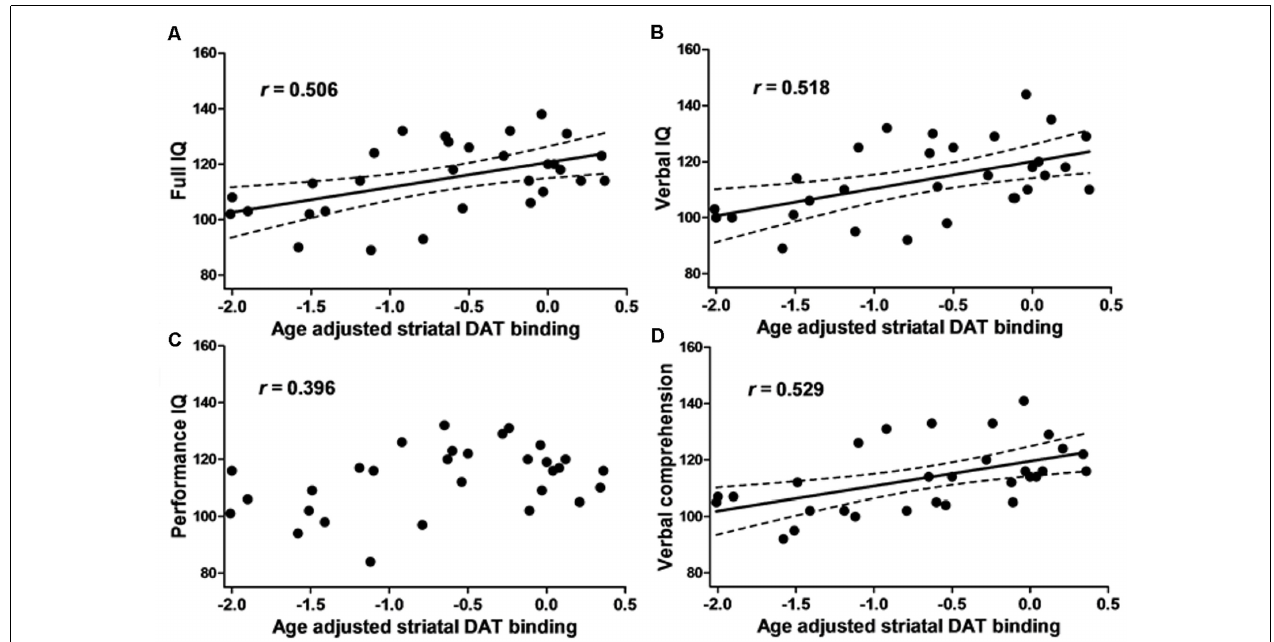
FIGURE 2 | The relationship between the intelligence quotient (IQ) and dopamine transporter (DAT) binding. The scatter plot showing the age-adjusted intellectual score and age-adjusted right and left averaged striatal specific binding ratio (SBR) of [ 123 I]-FP-CIT SPECT in 30 healthy subjects. (A) The full IQ, (B) Verbal IQ (VIQ) and (D) verbal comprehension were positively correlated with the striatal DAT binding. (C) Performance IQ (PIQ), working memory, perceptual organization and processing speed (see text) did not show any correlation. The dotted line represents the 95% confidence